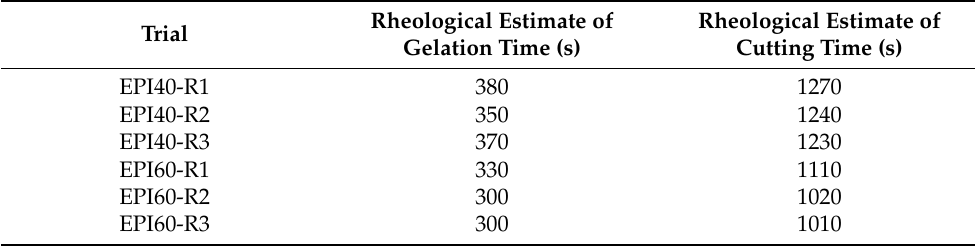
Table 1. Rheological parameters extrapolated from the elastic modulus curves obtained for each replicate of the mix ratio coagulation